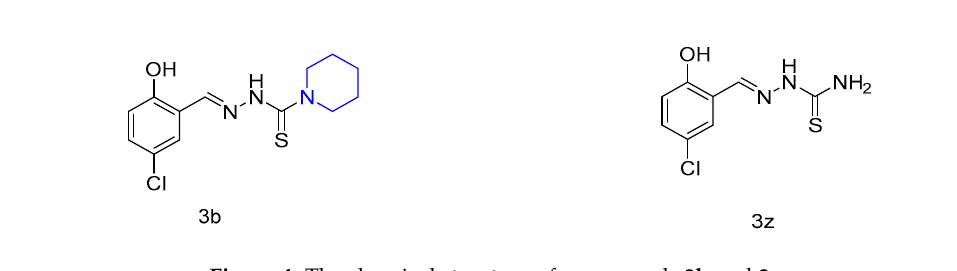
Figure 4. The chemical structure of compounds 3b and 3z .